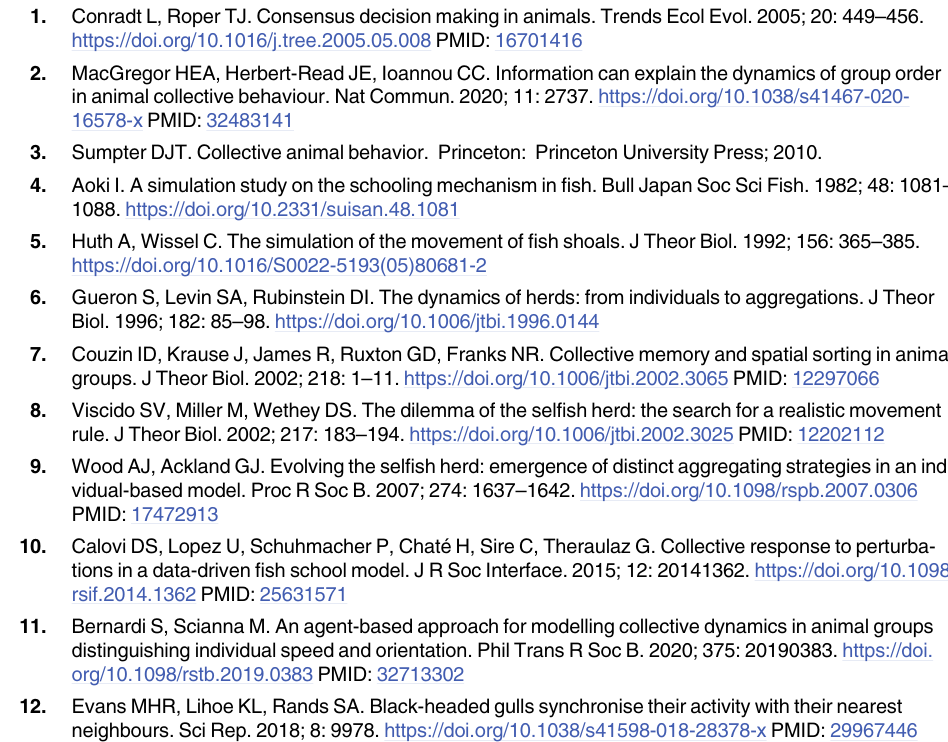
S6 Fig. The effects of the distance to the foraging site d conducting different social behaviours. See the legend to S4 Fig for details. S7 Fig. The effects of group size n on group performance when conducting different social behaviours. See the legend to S4 Fig for